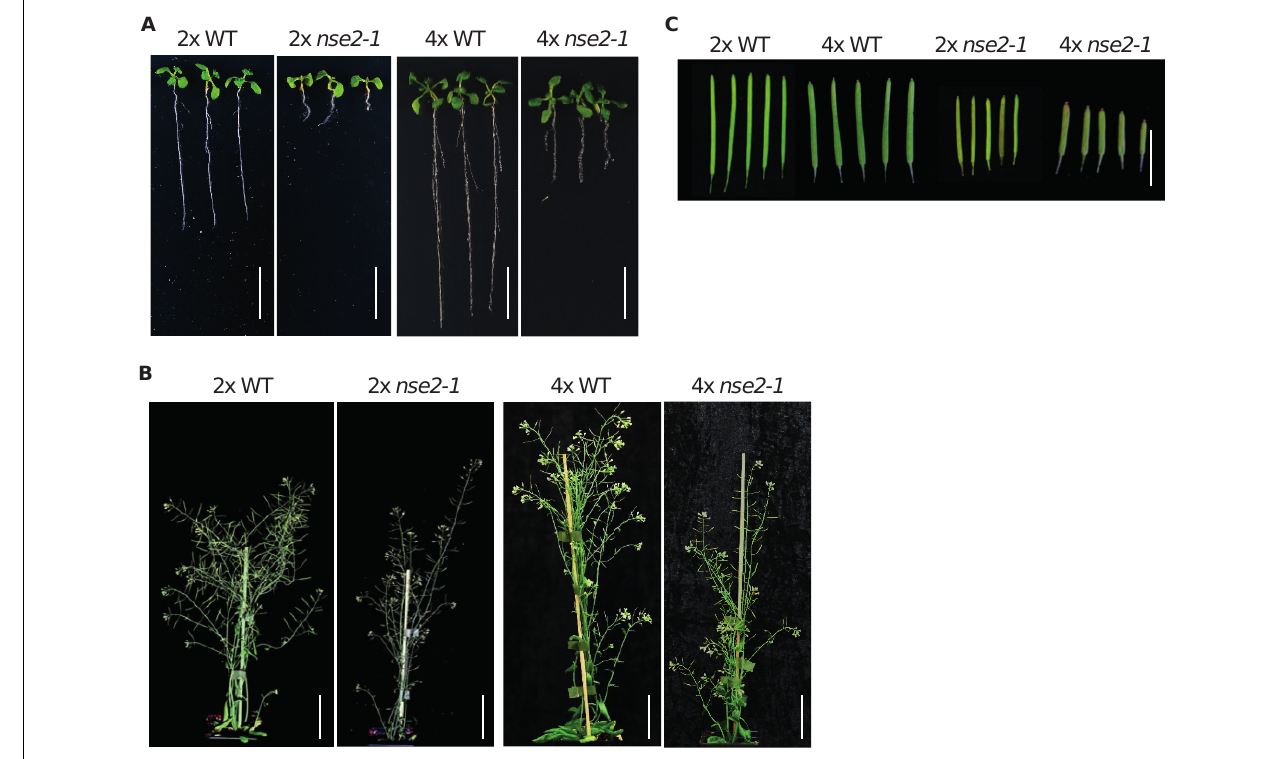
FIGURE 1 | Developmental phenotype of diploid (2x) and tetraploid (4x) WT and nse2-1 plants. (A) The phenotype of 2-weeks-old in vitro grown seedlings. Scale bar = 1 cm. (B) The whole plant phenotype of 5-week-old plants. Scale bars = 5 cm. (C) Representative siliques of the analyzed genotypes. Scale bar = 1 cm.